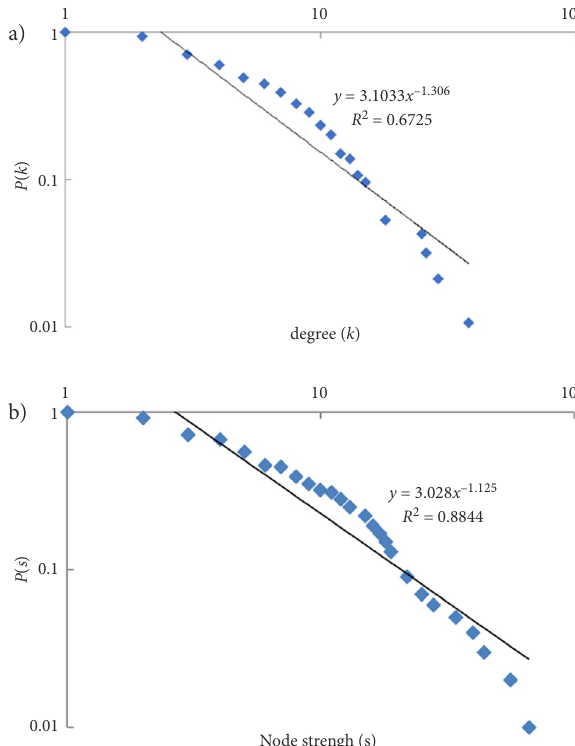
Figure 6. Nodes with all strength values greater than 14